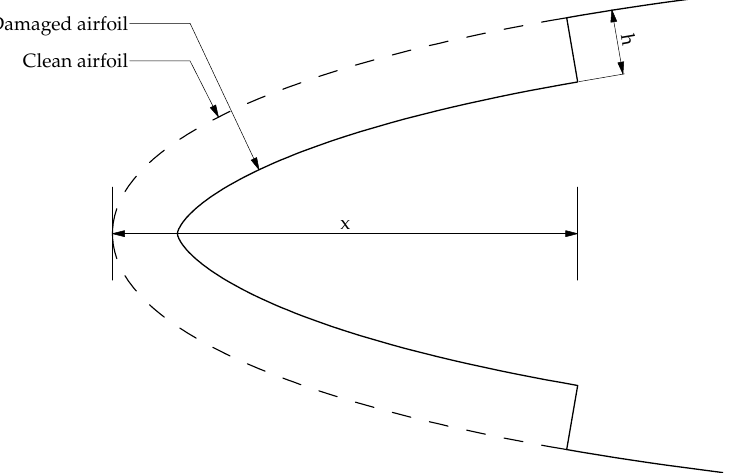
Figure 5. Geometrical representation of the LEE configuration. The chordwise delamination extent is denoted with the letter x and the delamination depth is denoted with the letter h